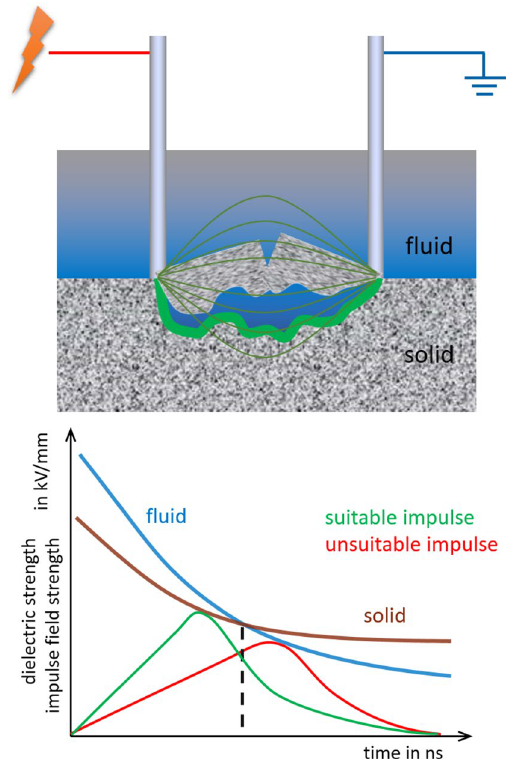
Fig. 1 Schematic electrode arrangement and principle of Electric Impulse Technology